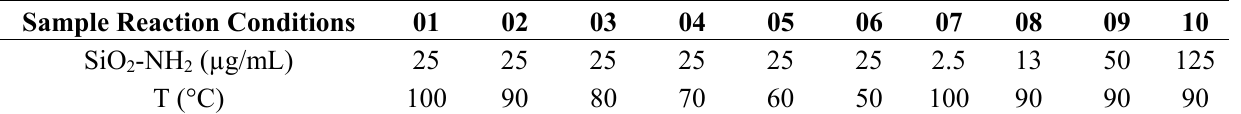
Table 1. Reaction temperatures and amount of SiO 2 -NH 2 particles used in the syntheses 01–10. Sample Reaction Conditions